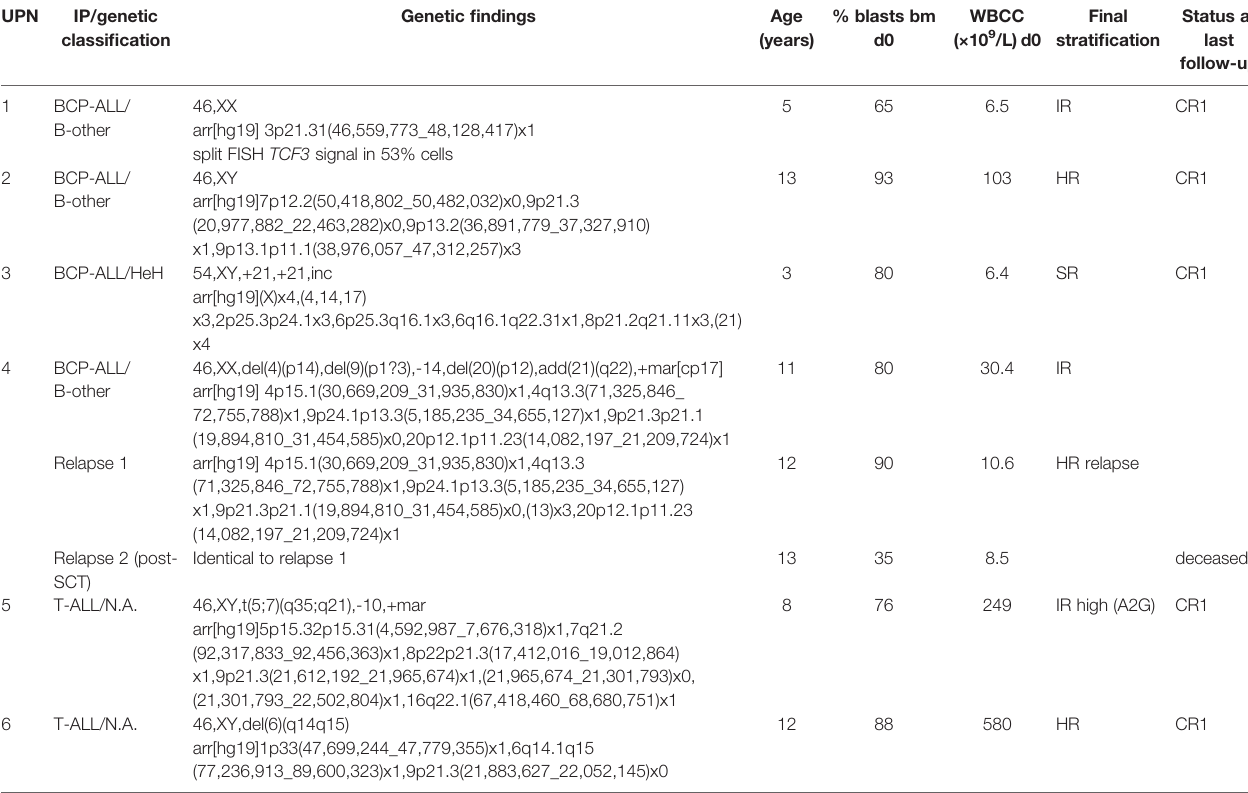
TABLE 1 | Patient